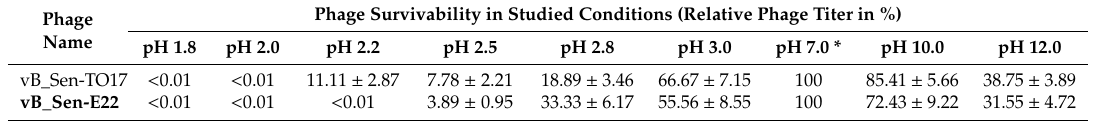
Table 3. Susceptibility of phages vB_Sen-TO17 and vB_Sen-E22 to di ff erent pH.